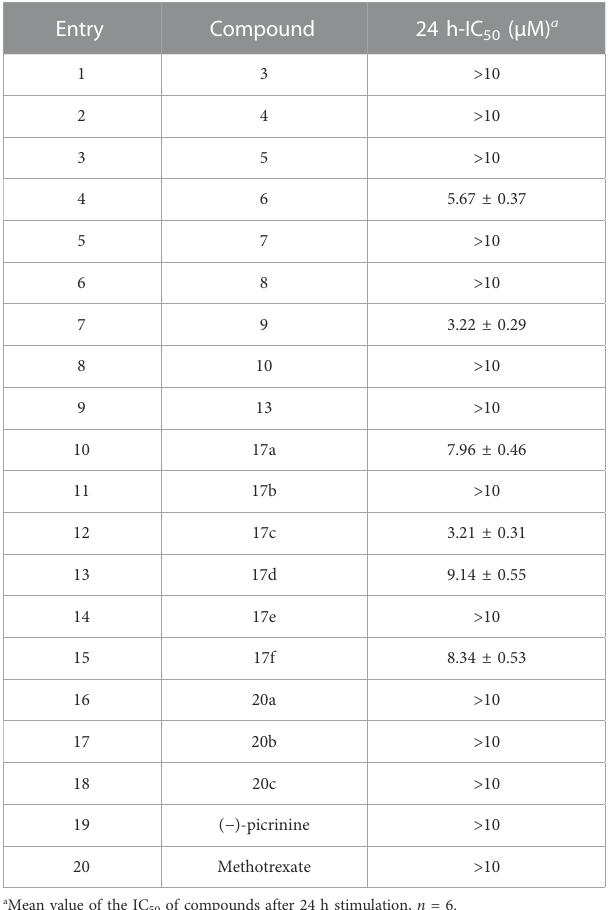
TABLE 1 24h- IC 50 of compounds on MH7A cells .